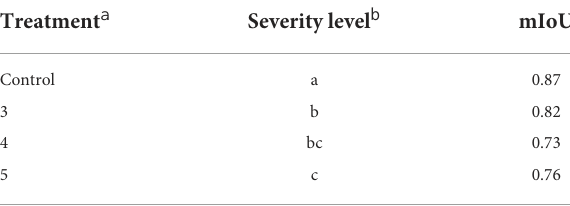
TABLE 2 Per-treatment downy mildew infection segmentation